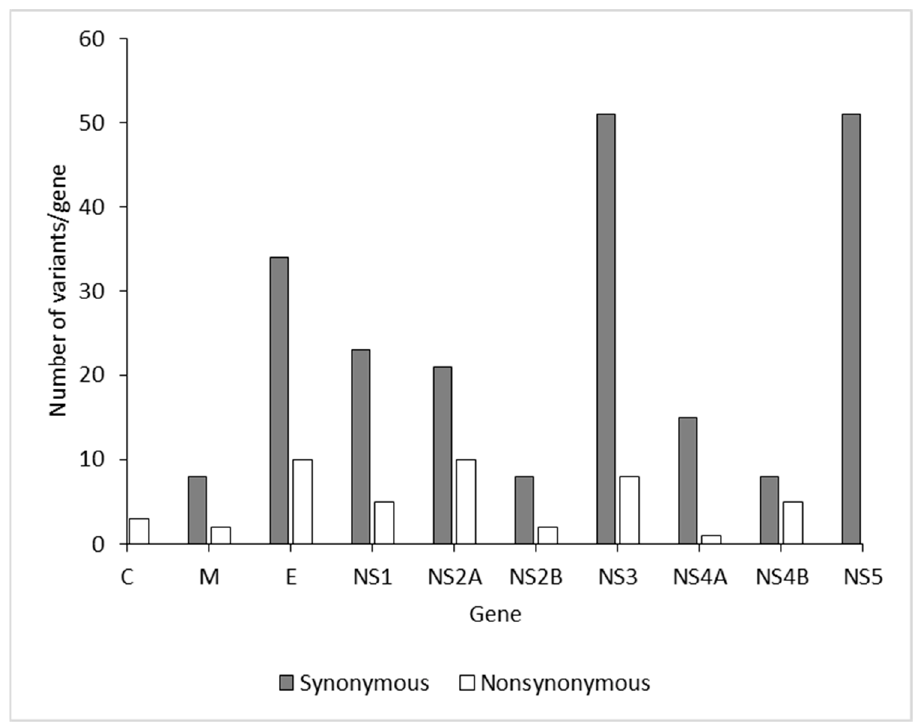
Figure 5. Positions with variant incidence > 1% per gene among the DENV-2 isolates from the 2017 outbreak in Nepal.